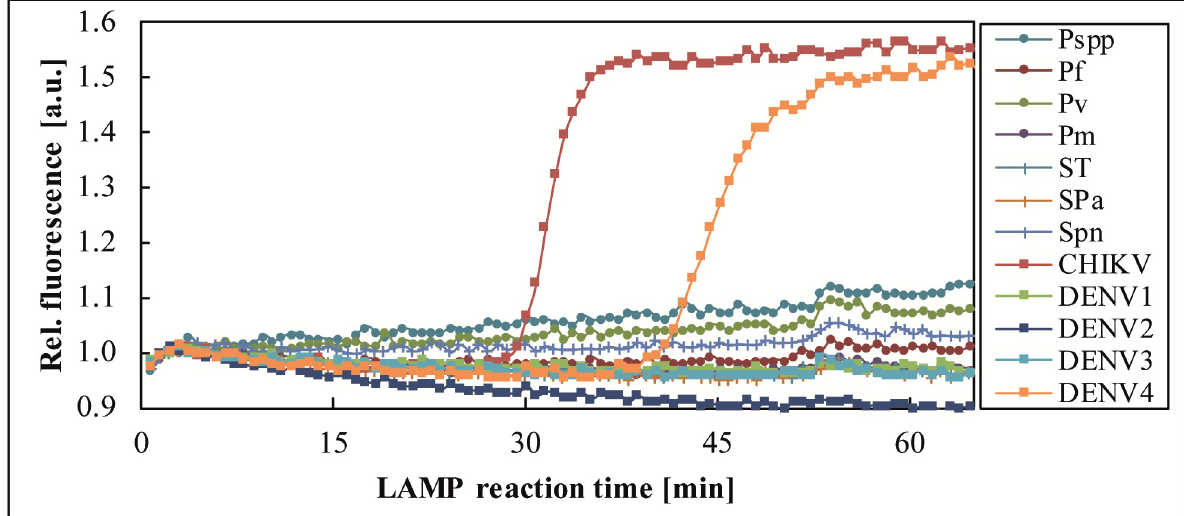
Fig 3. Detection of CHIKV and DENV4 co-infection in sample 274755. The FeverDisk showed a true positive DENV4 amplification in addition to the CHIKV-expected amplification.